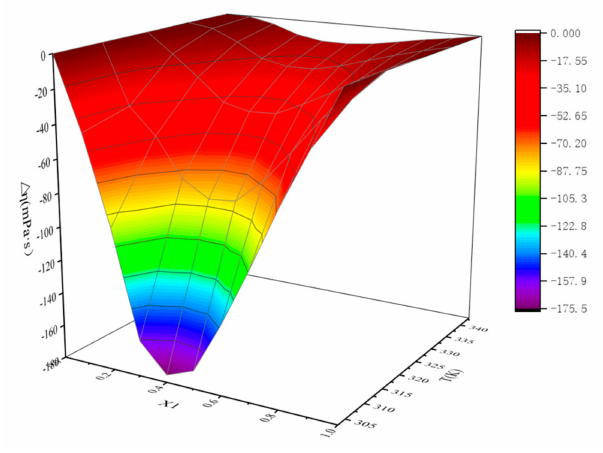
Figure 4. Viscosity deviations of {[EMIM] [TFA] ( χ 1 ) + TEA (1 − χ 1 )} binary systems.